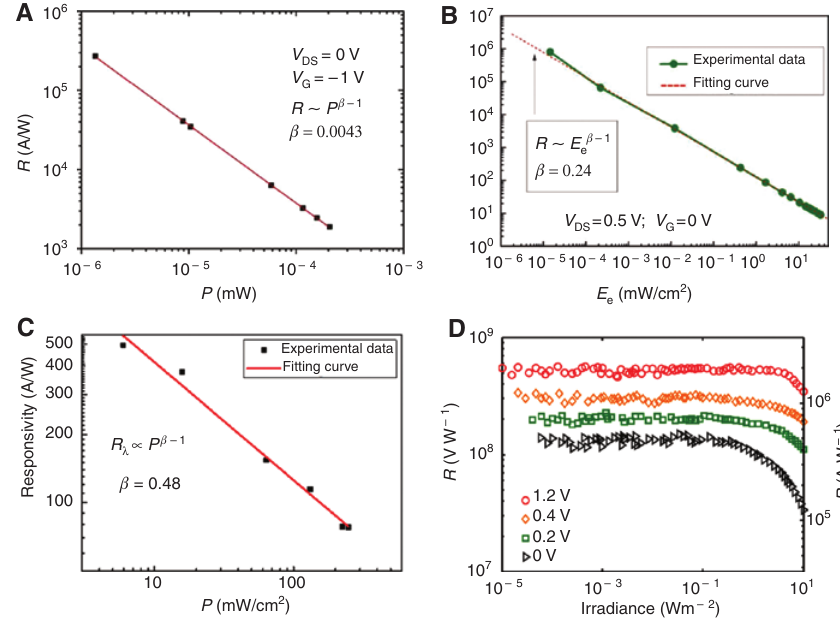
Figure 9: Responsivity vs. electromagnetic power: the graphene transistors with PbS QDs with different ligands (A) [23], (B) [10], and (C) [62]; (D) integrating diode-transistor detector based on graphene with PbS QDs